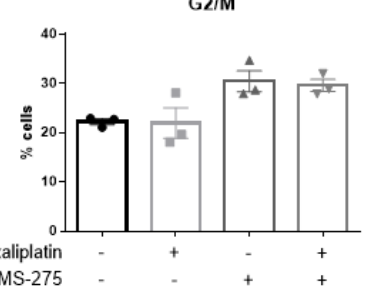
Figure 5. Oxaliplatin and MS-275 effects on in human colon cancer cell lines viability and cell cycle. Oxaliplatin dose-dependently inhibited survival of T84 ( A ) and HT29 ( B ) colorectal cancer cells as measured by inhibition of mitochondrial dehydrogenase activity (MTT assay). MS-275 dose-dependently inhibited survival HT29 cells ( B ) while significantly decreasing T84 cell viability only at the highest dose tested ( B ). Combined effect of oxaliplatin (16 µM) and MS-275 (2.5 µM) on T84 ( C ) and on HT29 ( D ) cell viability and on T84 ( E ) and HT29 ( F ) cells cycles. The average results from at least three independent experiments are presented. Values are expressed as mean ± SEM. Statistical analysis was performed using two-way ANOVA, detailed in Supplementary Table S1, with Tukey’s multi-comparisons post-hoc test; * for p < 0.05; ** p < 0.01, *** p < 0.001, versus the vehicle group; ° for p < 0.05, °°° for p < 0.001, versus the oxaliplatin group; ¤¤ for p < 0.01, ¤¤¤ for p < 0.001, versus the MS-275 group.